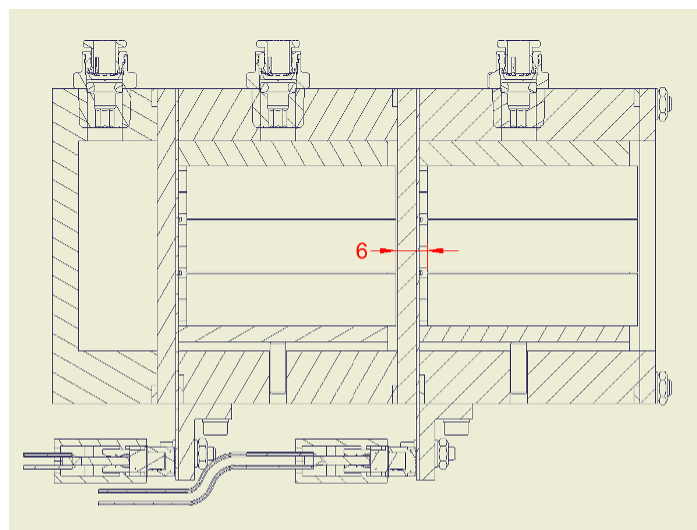
Figure 4. Top view of the